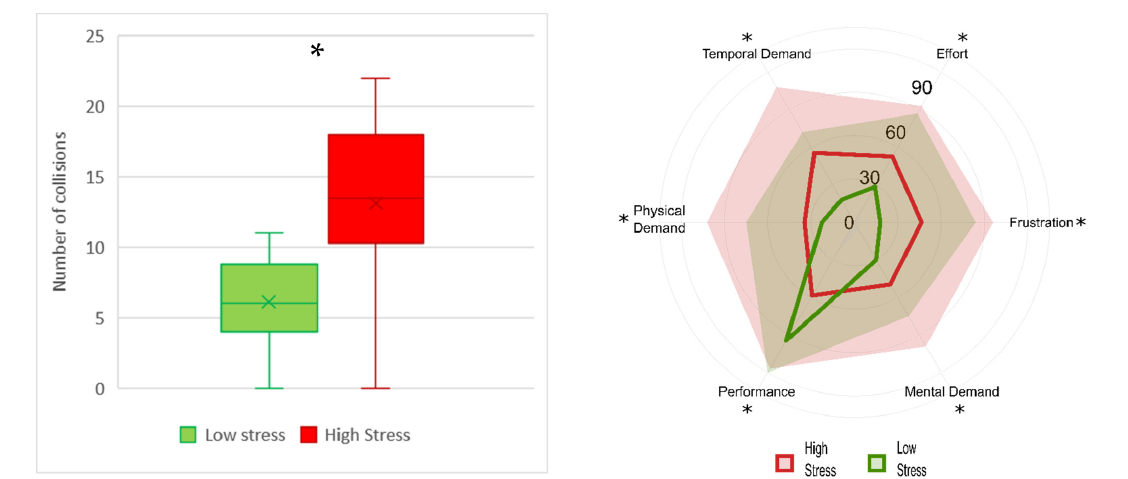
Figure 6. Boxplot representation of the number of collisions ( left ) and radar chart of NASA-TLX subscales ( right ). In the radar chart the lines represent the median of each subscale and the shaded areas the maximum value in the population. The low-stress condition is represented in green, and high-stress in red. The asterisks show the p < 0.05 resulting from the Wilcoxon signed-rank test. Figure 7 shows the statistical comparison between the RF-cross, RF-intra, Neurometric and SCL for the driving experiment. Additionally, in this case, as the time resolution decreases, the performance increases. The Friedman test is significant for each decimation ( p < 0.001 in each case). However, the post hoc analysis shows significant differences only for 1 and 10 s decimations. RF-cross performs significantly worse than SCL (Z = − 3.27, p = 0.001), and Neurometric (Z = − 2.67, p < 0.01) for 1 s of decimation, and significantly worse than Neurometric (Z = − 2.14, p = 0.03) for 10 s of decimation. In this case, the RF-cross shows the highest dispersion (Table 3).